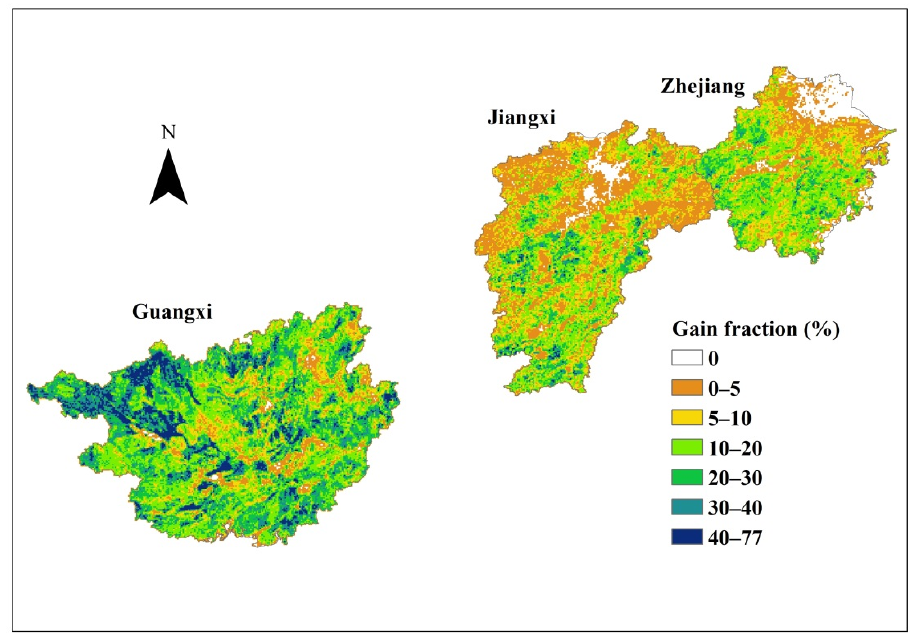
Figure 11. The aggregated (3 km × 3 km) total forest gain fractions in the Guangxi, Jiangxi, and Zhejiang Provinces during 1986–2015.